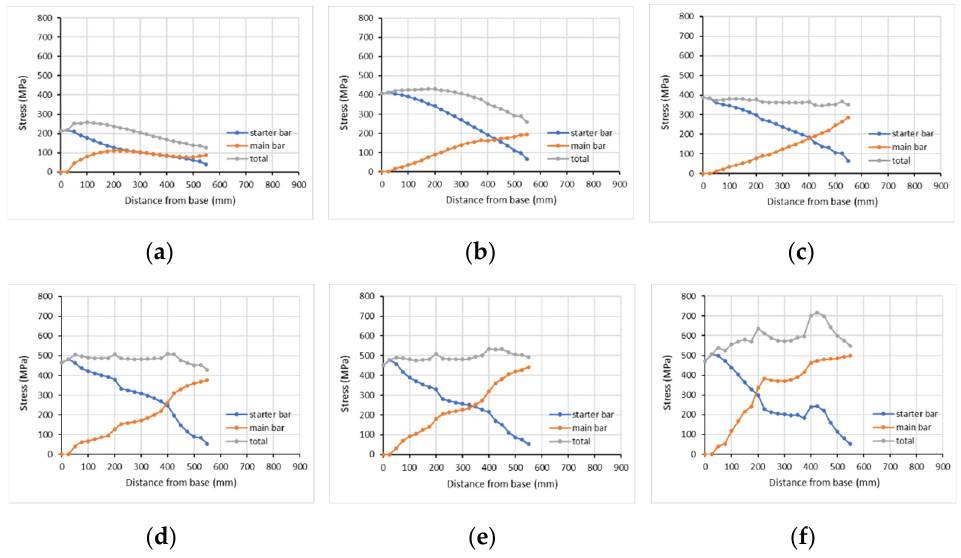
Figure 16. Developed stress along lap splice length at a displacement of ( a ) 3.44 mm, ( b ) 7.23 mm,